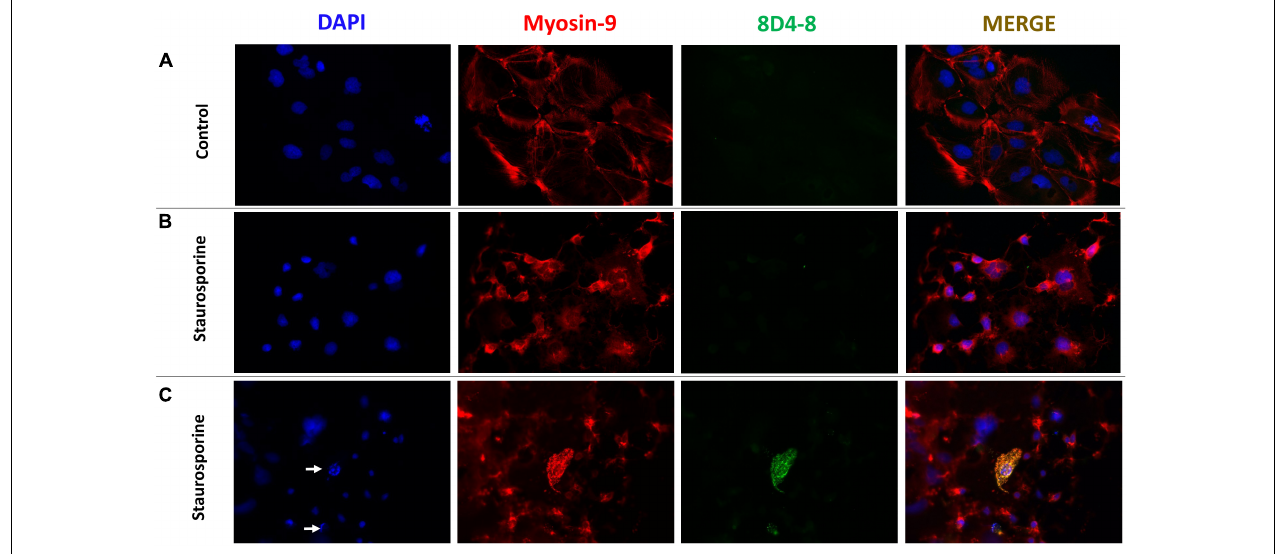
FIGURE 7 | 8D4-8 and myosin-9 colocalize among apoptotic cells. (A) We observed no detectable 8D4-8 expression among healthy control Caco-2 cells. (B) The majority of staurosporine-treated Caco-2 cells show retracted processes and more condensed cytoplasm, but do not bind 8D4-8. (C) Scattered among the staurosporine-treated cells were 8D4-8 + cells. These cells were limited to those in apparent apoptosis. Note the condensed chromatin (white arrows) associated with the 8D4-8 + cells. For (A–C) , blue is DAPI, red is myosin-9, and green is 8D4-8. Images were acquired at 200 × magnification. Results are representative of 3 experiments.